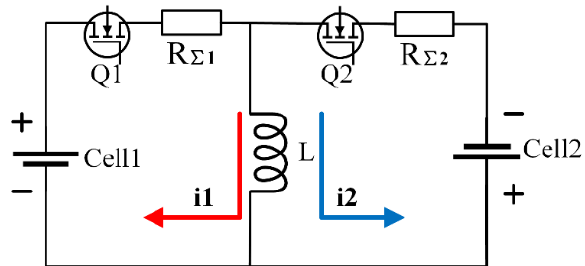
Figure 5. Equivalent model of the main circuit.